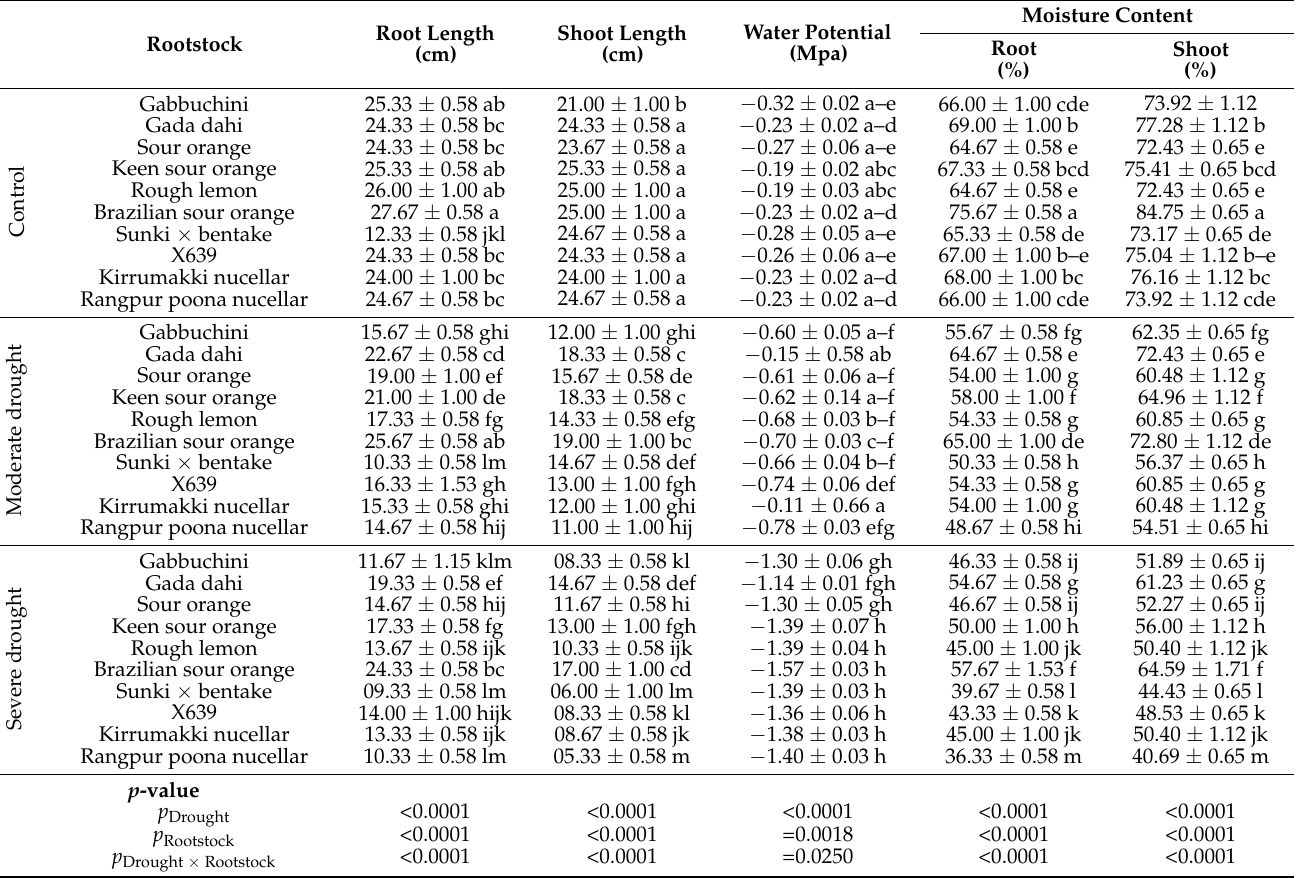
Table 2. Effect of different water regimes on the root length (cm), shoot length (cm), and water relations of 10 differentcitrus rootstocks with distinct degrees of tolerance to drought stress.